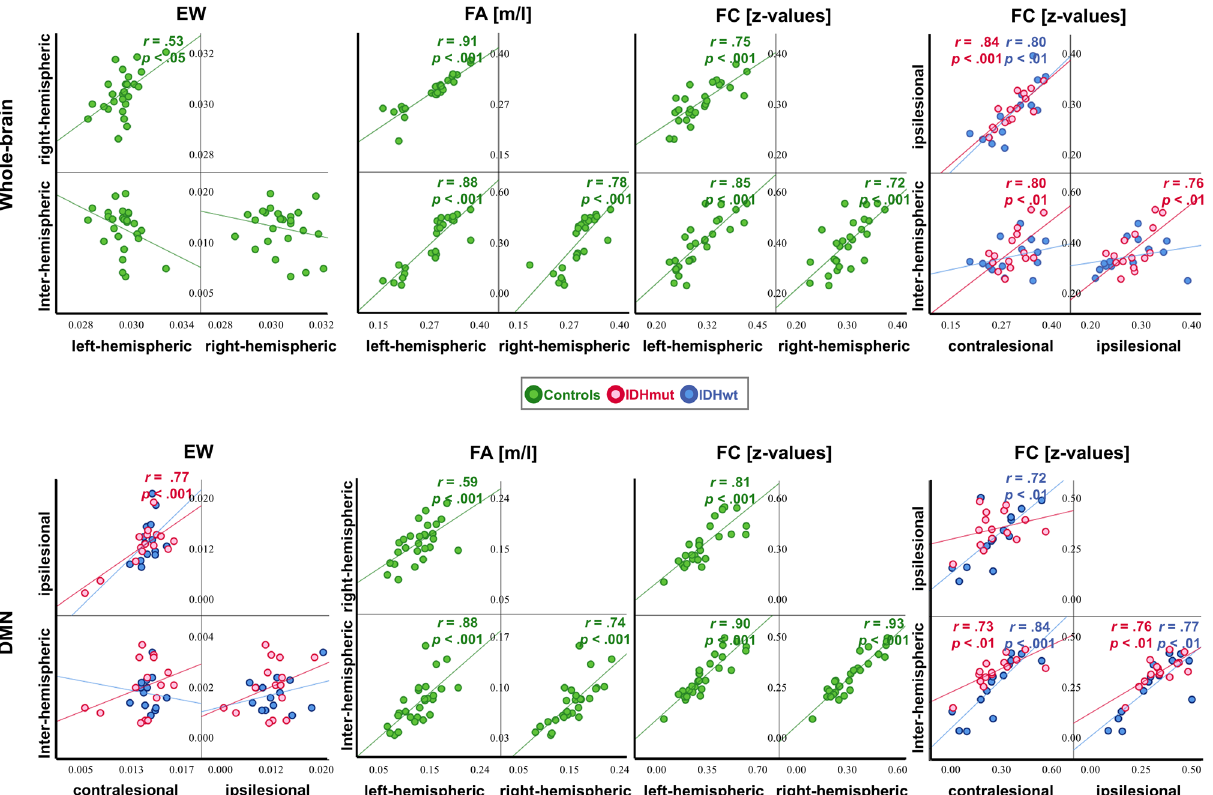
Figure 5. Intramodal structural and functional connectivity correlations. Significant intramodal correlations are visualized for edge weight (EW), fractional anisotropy (FA) and functional connectivity (FC) for healthy controls (green), and isodehydrogenase-mutated (IDHmut, pink), and IDH-wildtype gliomas (IDHwt, blue), and are marked with the correlation coefficient (r) and the significance (p). Significances for each analysis were computed two-sided with a significance level of p < .05 and corrected for multiple comparisons, corrected p value: p <